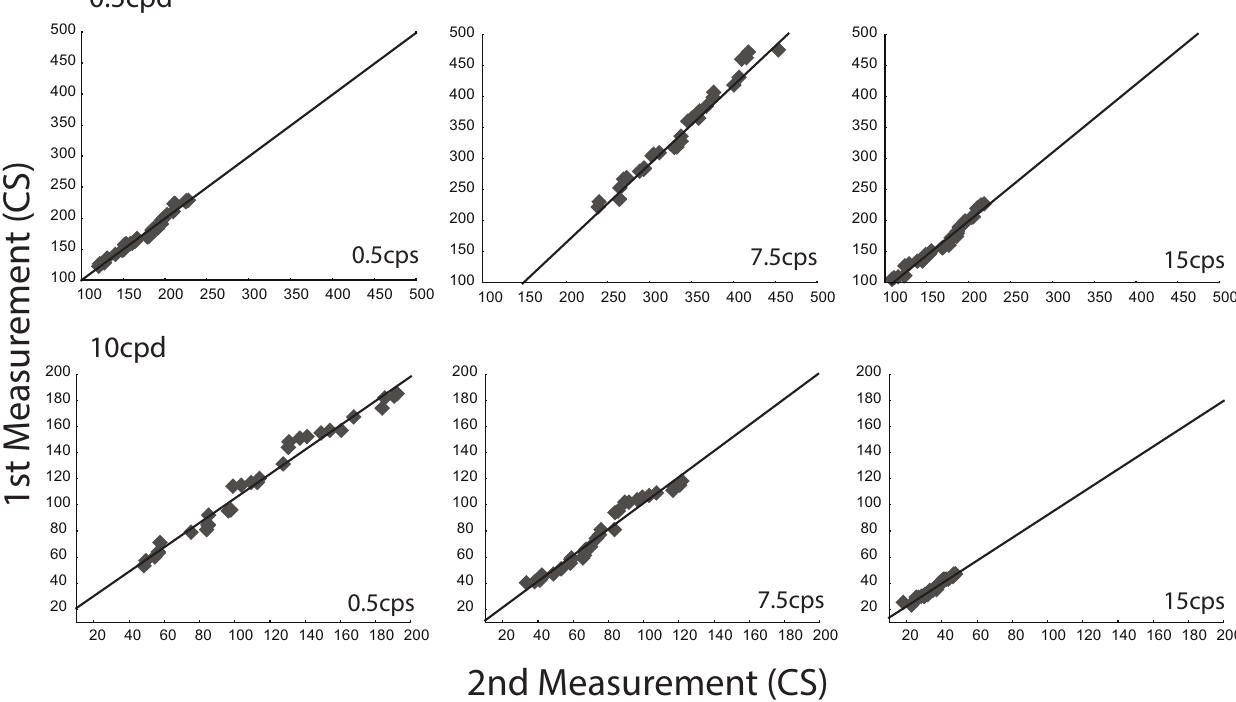
Figure 3. Correlations between the first and second measurements for reliability purposes. A strong correlation is evident for both low and high spatial frequencies in all temporal